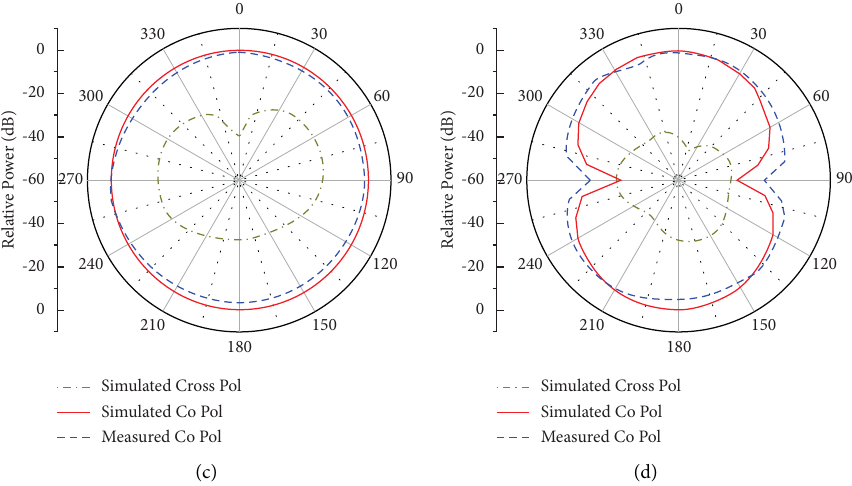
Figure 9: Normalized radiation patterns: (a) xz -plane, 2.72 GHz; (b) yz -plane, 2.72GHz; (c) xz -plane, 4.58GHz; (d) yz -plane, 4.58GHz of proposed dual-band MTM antenna.